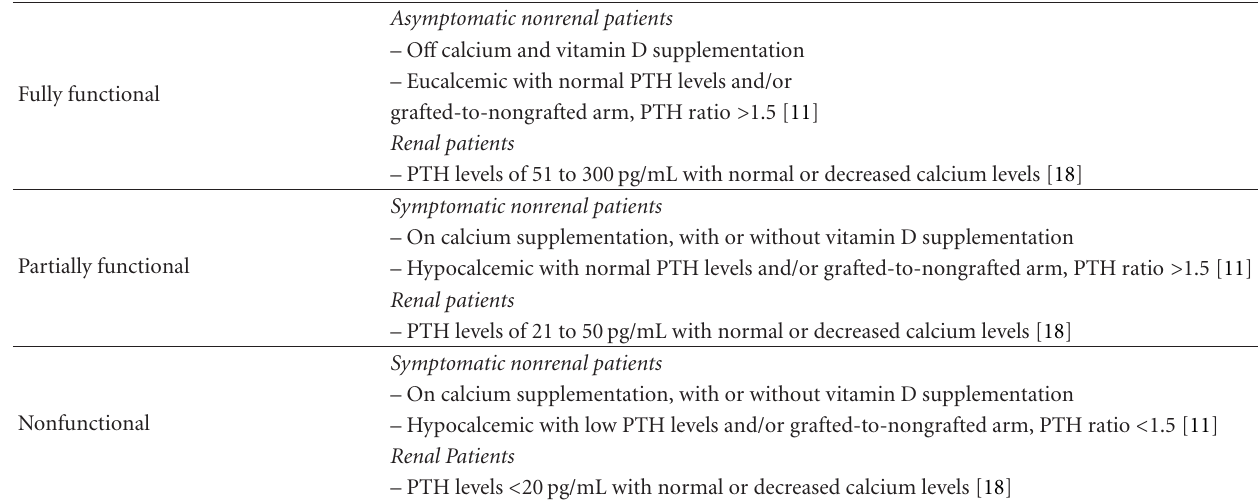
Table 2: Definitions of parathyroid graft